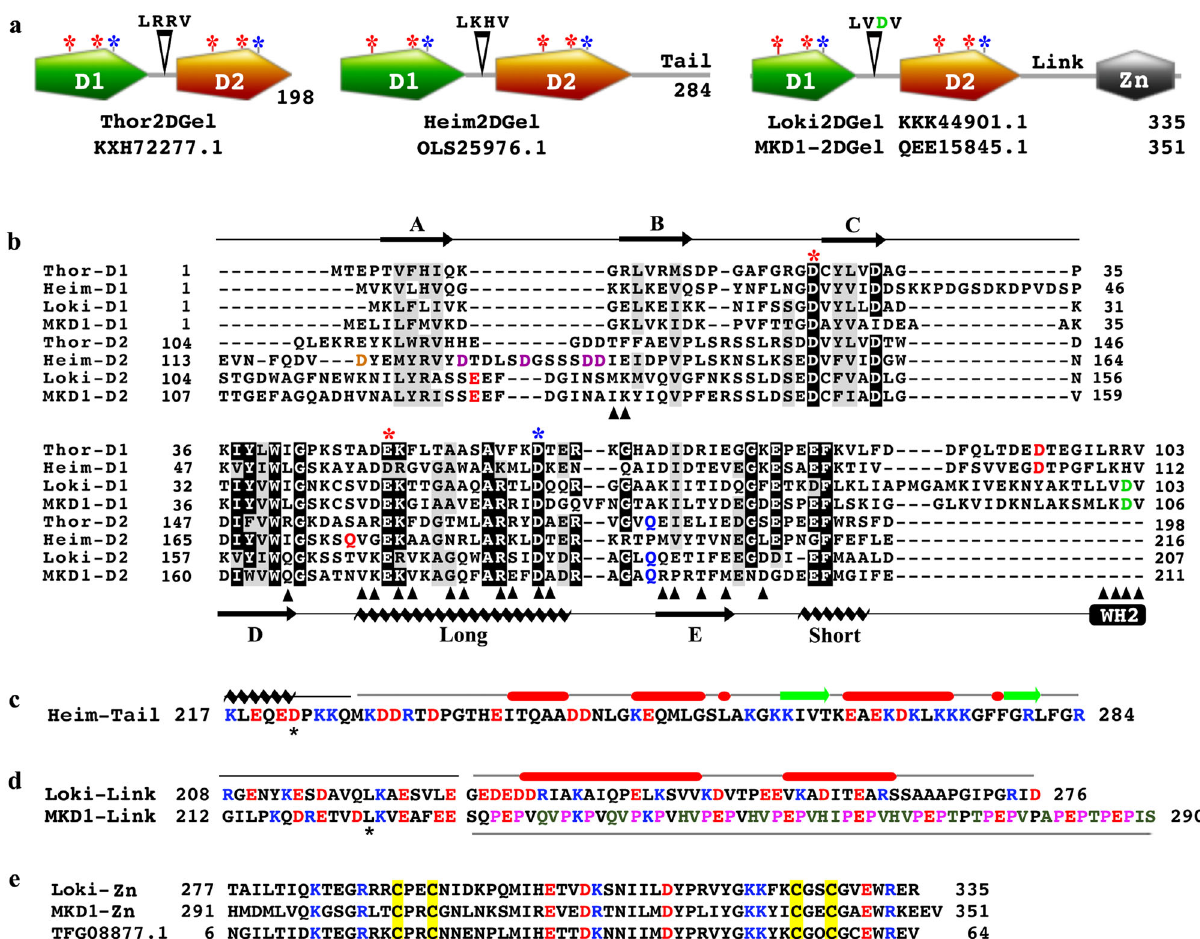
Fig. 1 Sequence analysis of 2DGels. a Schematic comparison of Thor2DGel with the extended Heim2DGel, Loki2DGel and MKD1-2DGel 5 . Asterisks indicate signature calcium-binding residues, Type I binding sites (blue) and Type II binding sites (red) 19 . The WH2-like motif appears between domain 1 (D1) and domain 2 (D2) and central “ LKKT ” -like 4 amino acids are indicated 24 . The Loki sequences have an unusual WH2-like motif “ LVDV ” in which the aspartic acid is highlighted in green. The C-terminal extended regions are referred to as Tail, Link and Zn. The protein sequence lengths are indicated. b Sequence alignment of the eight gelsolin domains from ( a ) based on the crystal structures determined in this manuscript. Secondary structure elements for Loki-D1 (Loki2DGel domain 1) are indicated above and below the alignment (black). Asterisks indicate signature calcium-binding residues, as in (a). Colored residues indicate additional calcium-binding sites. Black triangles indicate the actin-binding residues for Loki-D1. c Sequence of the Heim2DGel Tail. The fi rst 10 residues are ordered in the crystal structure and include a helix and a calcium-binding residue (Asp222, black asterisk). The remaining residues are disordered in the crystal structure and their predicted secondary structure is indicated above, helices in red and strands in green 32 . Basic and acidic residues are colored blue and red. d Similar analysis for the linker regions of Loki2DGel and MKD1-2DGel. The fi rst 20 residues are ordered and extended in the Loki2DGel/actin structure and include a mainchain calcium ion interaction (Leu220). Beyond this region the linker regions are not homologous. Loki2DGel is predicted to be helical, while MKD1-2DGel contains repetitive 6 amino acid repeat pink and green sequences that are predicted to be extended 32 . e The predicted Zn 2 + -binding domain aligned with a 64 residue Loki protein. The Zn 2 + -binding residues are highlighted in yellow and conserved charged residues are